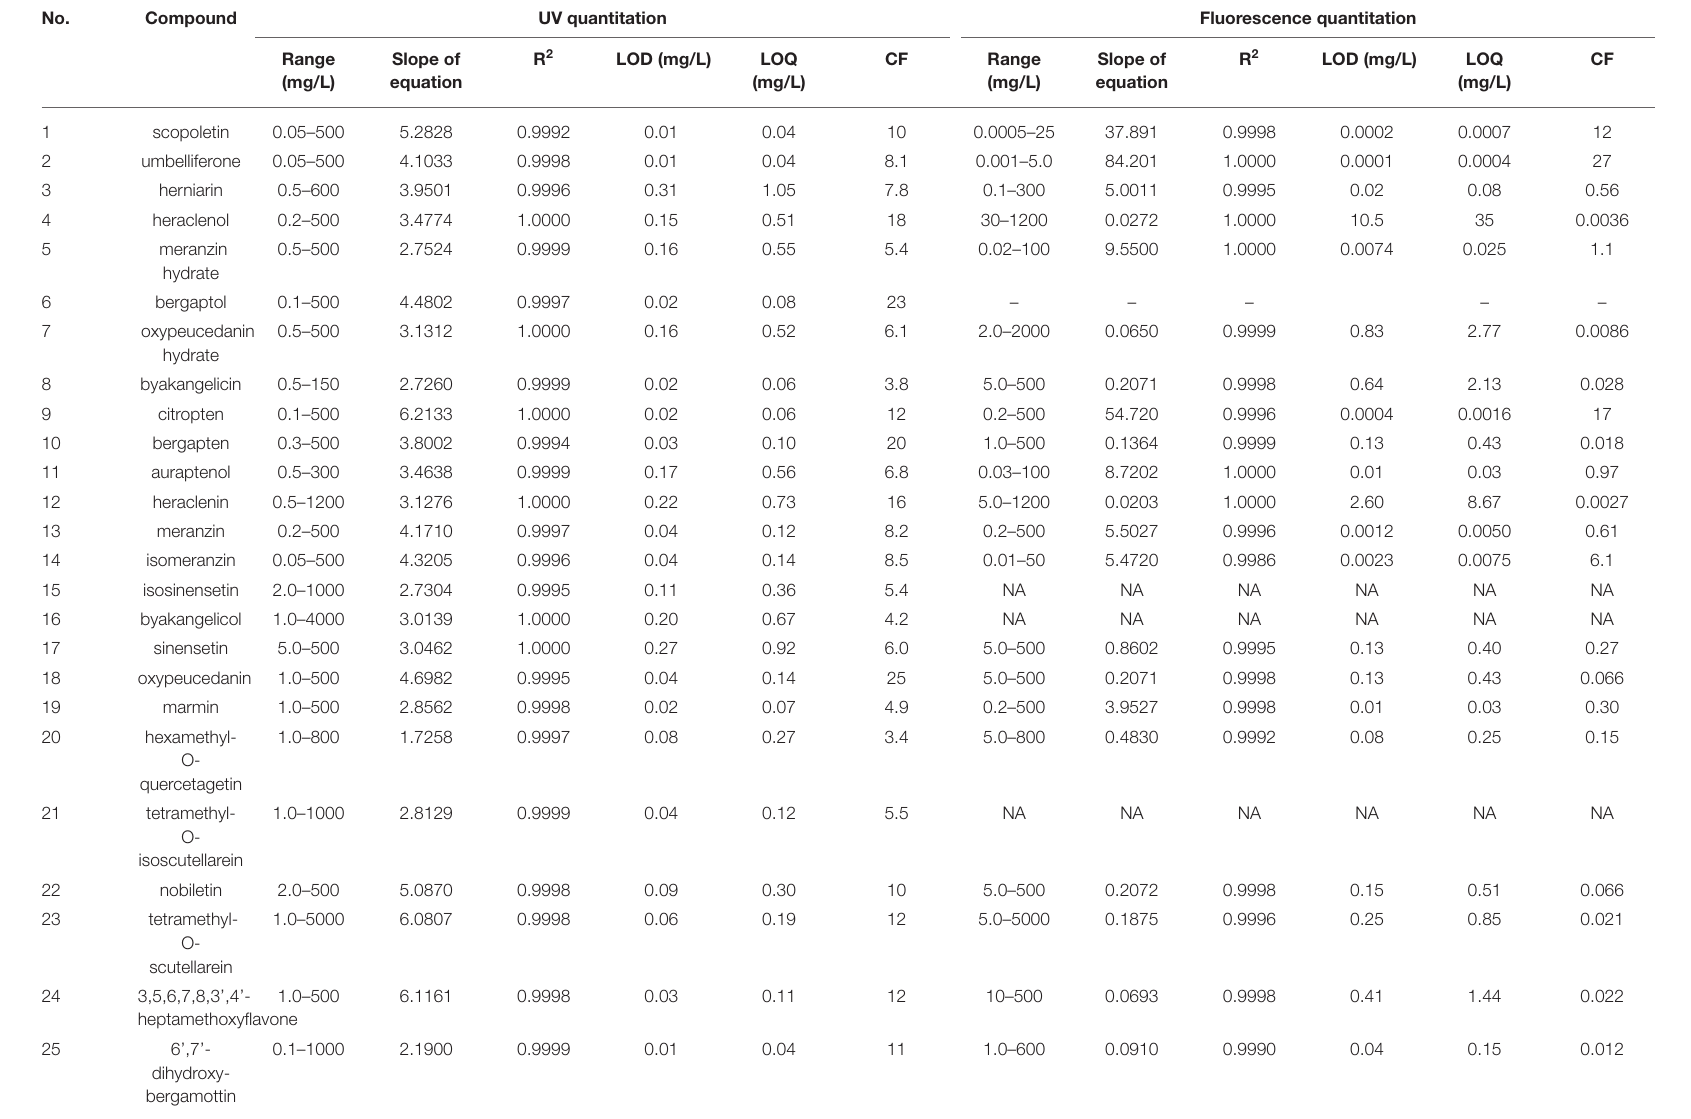
TABLE 2 | Calibration and quantitative parameters of the 39 OHAs.